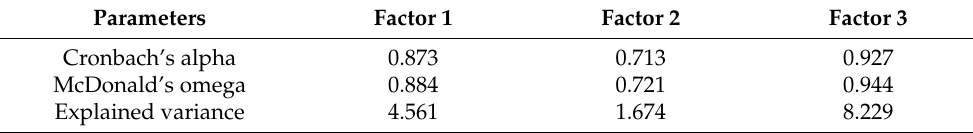
Table 7. Internal consistency parameters for the